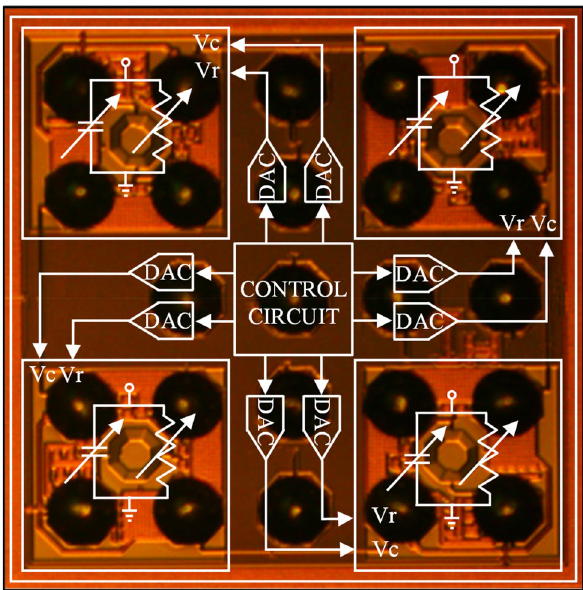
Figure 2. Microphotograph of the bottom side of ASIC Design 4.02 with the overlaid architecture. Large top- metal structures of the chip, such as inductors, can be seen between solder-bumps. The digital control circuitry is hidden behind metal-shielding